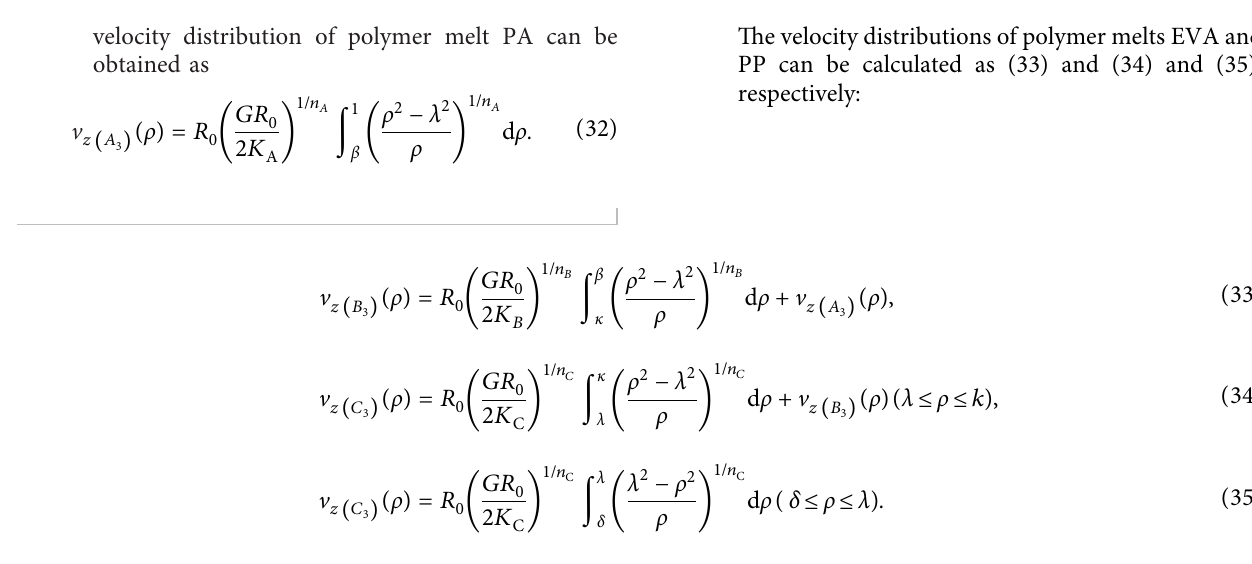
Figure 9: Graphics of cross sections of catheters at different screw speeds ( N (d) N w 4 � 12 r/min, (e) N w 5 � 14 r/min, (f) N w 6 � 16 r/min, (g) N w 7 � 18 r/min, (h) N w 8 � 20 r/min, (i) N w 9 � 22 r/min, (j) N w 10 � 24 r/min, (k) N w 11 � 26 r/min, (l) N w 12 � 28 r/min, (m) N w 13 � 30 r/min, (n) N w 14 � 32 r/min, and (o) N w 15 � 34